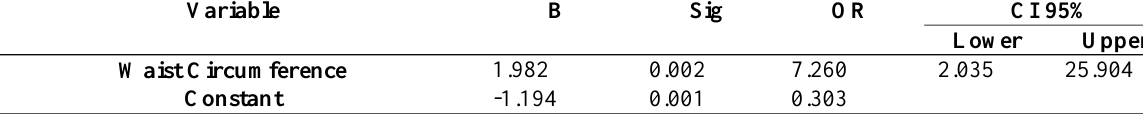
Table 4. The result of Third Step Model Regression Logistic